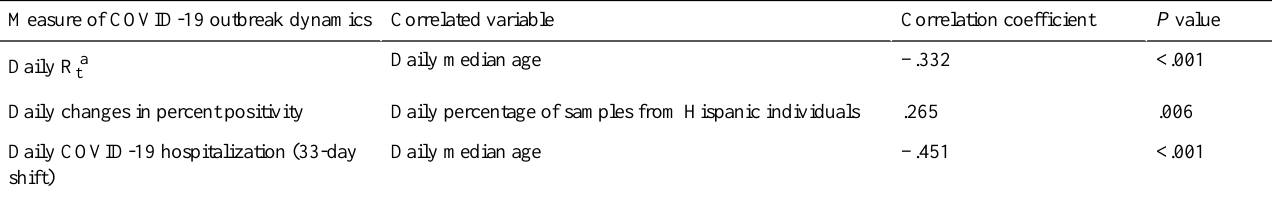
Table 2. Demographic factors of COVID-19 testing samples collected between September 15, 2020, and January 11, 2021, that were correlated with measures of COVID-19 outbreak dynamics during the sample collection